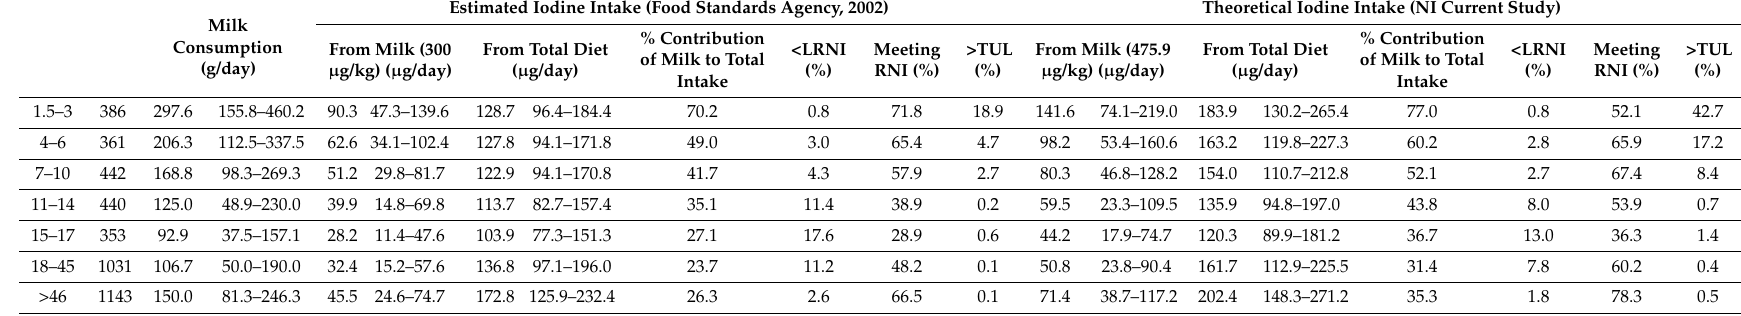
Table 2. Estimated iodine intake using National Diet and Nutrition Survey (NDNS) milk consumption data at iodine concentrations reported by the Food Standards Agency (2002) [23] and those measured in the present study of NI